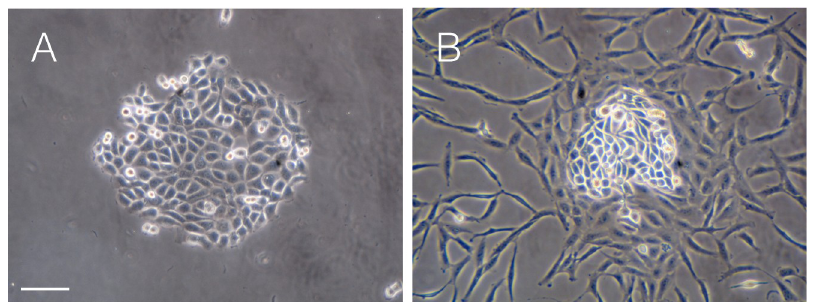
Fig 1. Co-culture of ACT1 cell cluster with NTECs. ACT1 cells were cultured for 5 days until they formed small cell clusters of approximately 500 μ m in diameter. Then, NTECs were added to establish co-cultures. (A) ACT1 cluster in monoculture at Day 7. (B) ACT1 cluster with NTECs two days after co-culture. NTECs were gradually crowded around ACT1 cell clusters. The bar in (A) indicates 100 μ m.